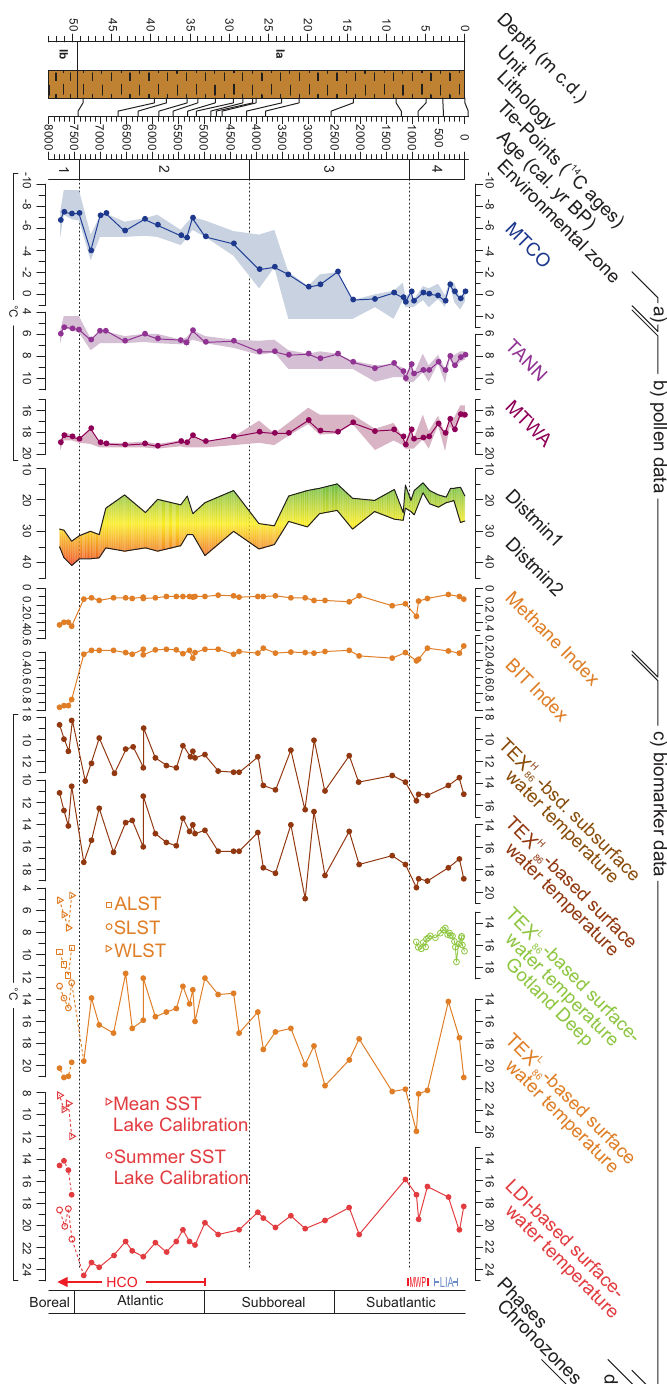
Figure 5. Sedimentological units, lithology (Andrén et al., 2015a), and position of 14 C ages (Van Helmond et al., 2017) vs. depth and IODP Site M0059 temperature proxies and related datasets plotted vs. age (extrapolated below ∼ 48.64 mc.d.). (a) Environmental zones (EZs) based on diatom data. (b) Pollen-inferred climate reconstructions based on the modern analogues technique, with the shaded area reflecting the range of the best eight analogues. Distmin1 and Distmin2 are the squared chord distance between fossil sample and the best to 8th-best modern analogues, indicating similarity between fossil and modern samples. (c) Methane and branched isoprenoid tetraether (BIT) indices, TEX H -based subsurface water temperature, TEX H -based surface water temperature, TEX L -based surface water temperature from the 86 86 86 Gotland Deep (Kabel et al., 2012) for comparison, TEX L -based surface water temperatures shown with lake calibrations for EZ1 (ALST: 86 annual, SLST: summer, WLST: winter lake surface temperatures), and LDI-based sea surface temperatures with lake calibrations for EZ1. (d) Climate phases and